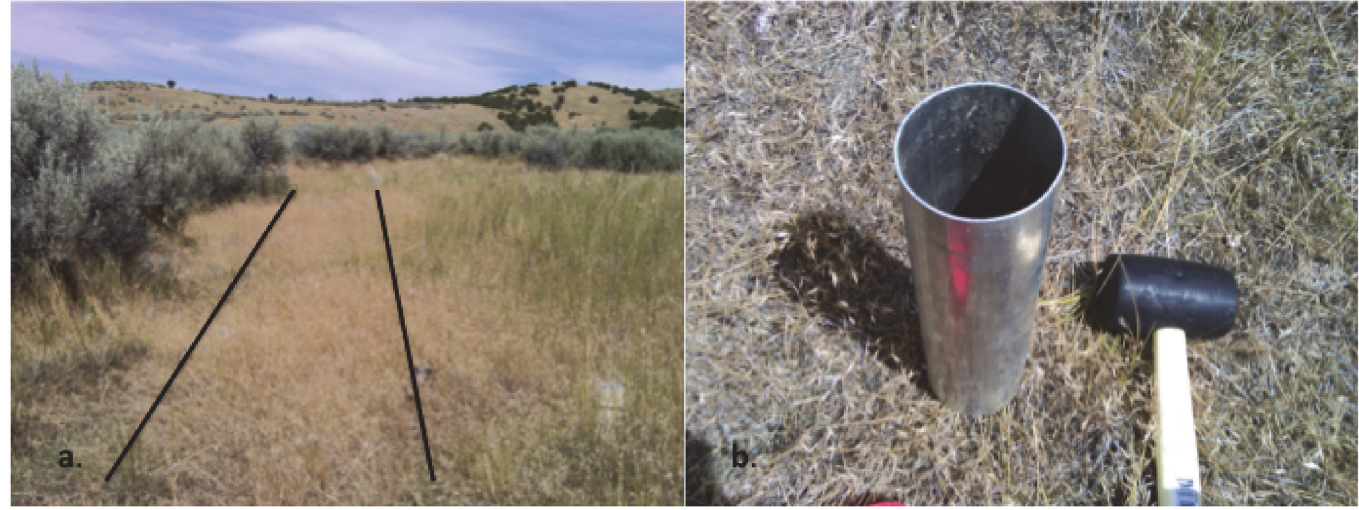
Figure 1. Shrub removal plot (a.) from which cheatgrass dominated soils (b.) were sampled and the adjacent area from which sagebrush- dominated soils were sampled. The black lines in panel a. outline the cheatgrass-dominated soils that were sampled in the 1 m × 20 m border of the plot; cheatgrass-dominated soils outlined in panel a. are shown up-close in panel b. Photos were taken by C.F. Weber at the time of sampling (September